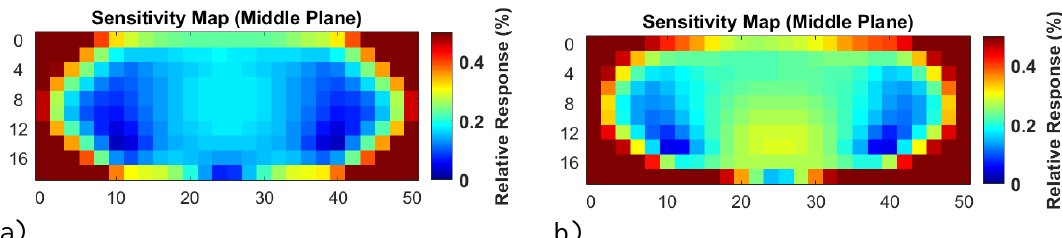
Figure 12. Calculated sensitivity maps for the undulator scanner. ( a ) The response function of the scanner for the horizontal middle plane of a cuboid is condensed to the RMS values for each point; ( b ) high-pass filtered response functions better account for the localization value of the signal.